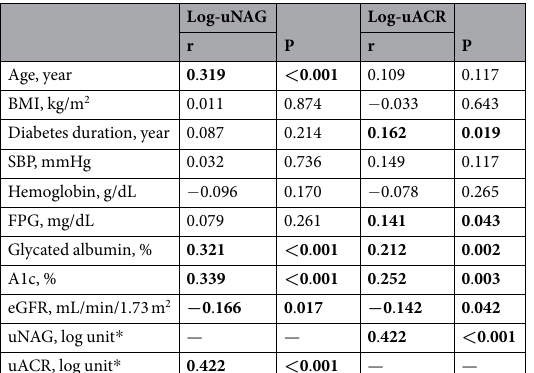
— Table 2. Correlation between urinary markers and glucometabolic parameters. * uNAG and uACR were log- transformed to achieve normal distribution for calculating Pearson correlation coefficients. Bold characters represent statistically significant values. Abbreviations: A1c, hemoglobin A1c; BMI, body mass index; SBP, systolic blood pressure; FPG, fasting plasma glucose; uNAG, urinary N-acetyl- β -D-glucosaminidase; eGFR, estimated glomerular filtration rate; uACR, urinary albumin-to-creatinine ratio.